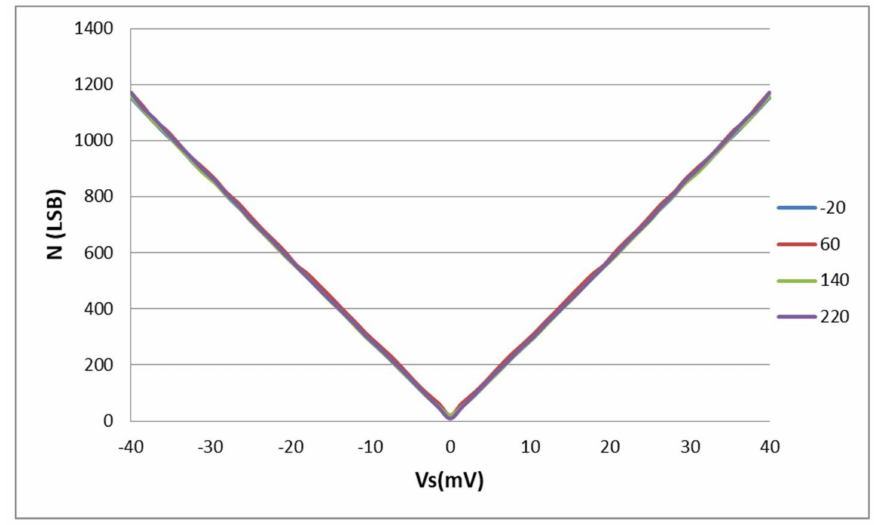
Figure 18. Experimental characteristic function of the sensor interface [ − 20 ◦ C, 220 ◦ C].